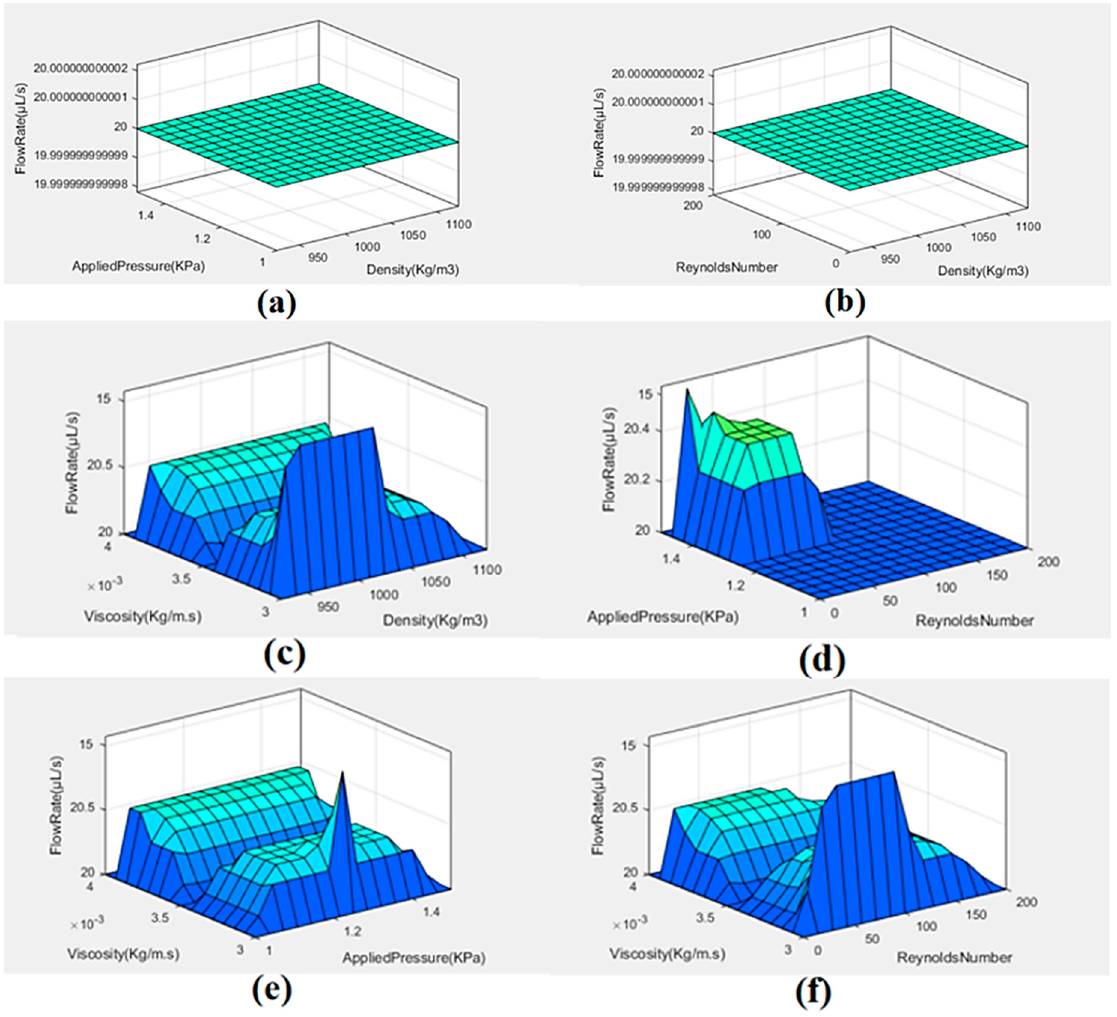
Figure 7. 3D graphical variations with inputs Reynolds number, applied pressure, viscosity, and density with flow rate as output ( a ) Variation for applied pressure with density and flow rate as output ( b ) Variation for Reynolds number with density and flow rate as output ( c ) Variation for viscosity with density and flow rate as output ( d ) Variation for applied pressure with Reynolds number and flow rate as output ( e ) Variation for applied pressure with viscosity and flow rate as output ( f ) Variation for Reynolds number with viscosity and flow rate as output. The three-dimensional graphs obtained for 5CDCMC from Fuzzy logic simulation with velocity as output are shown below in Figure 8.